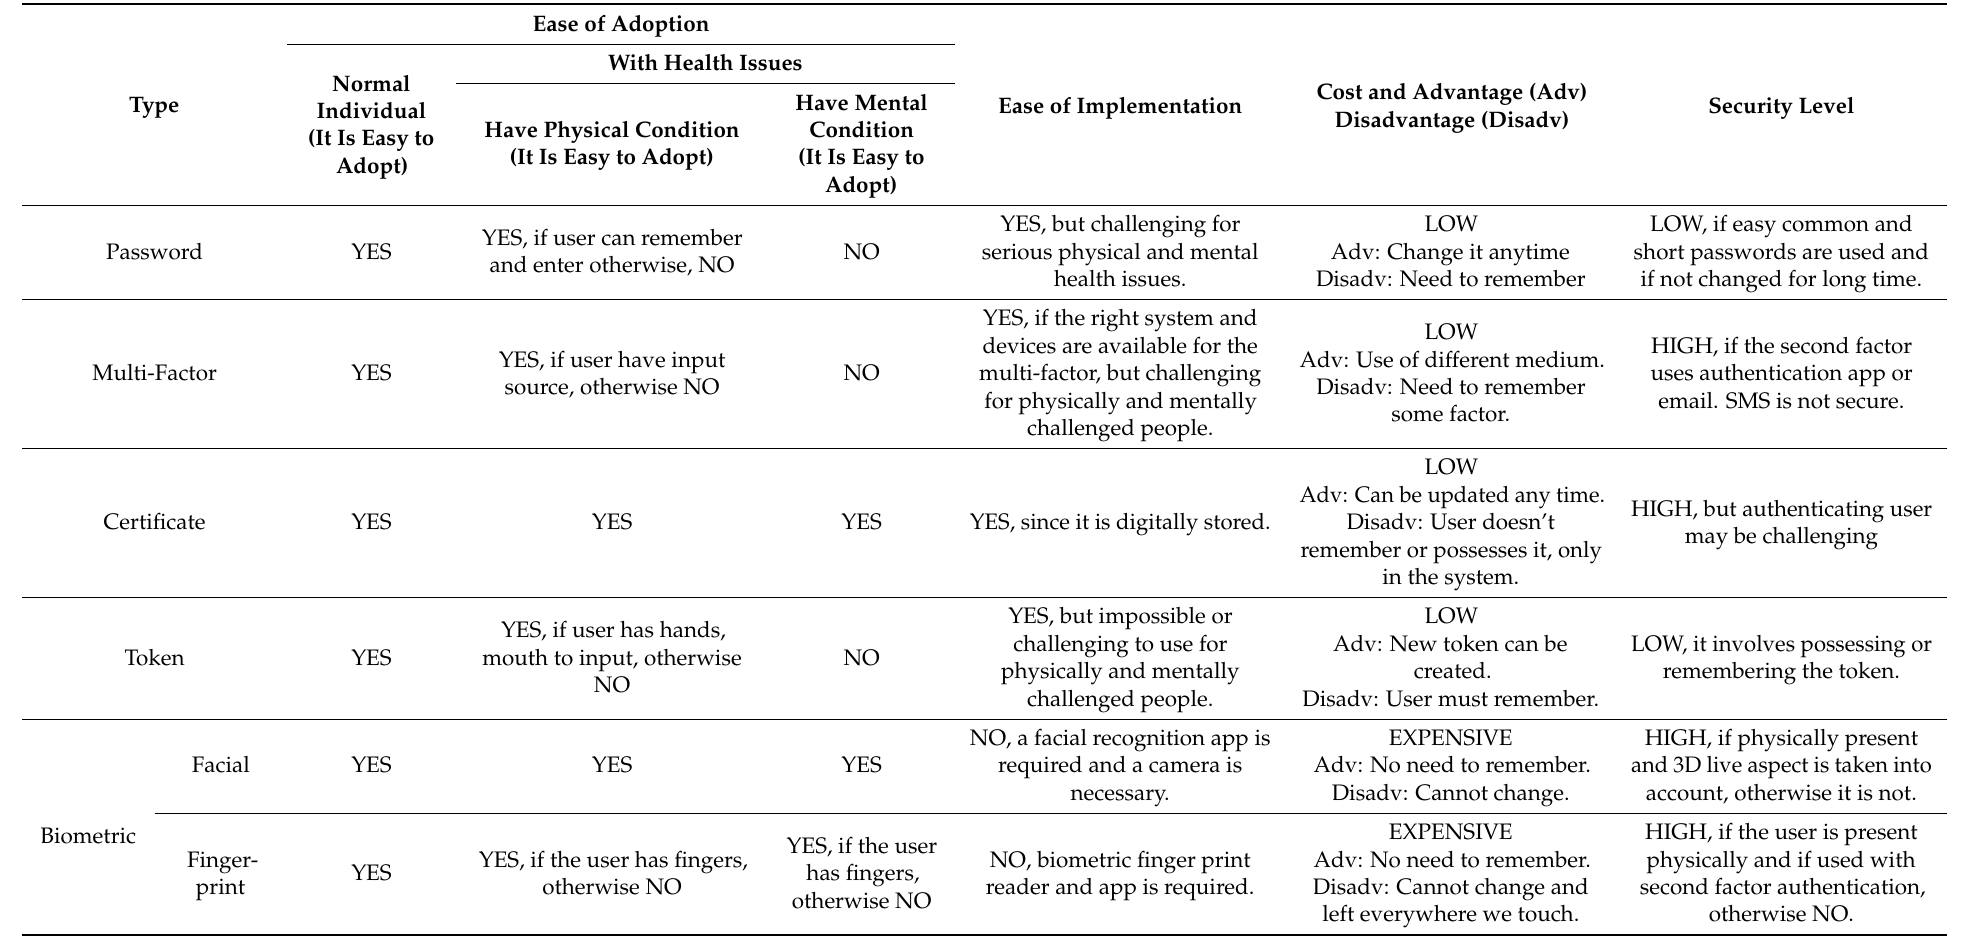
Table 3. Authentication Mechanisms and Adoption